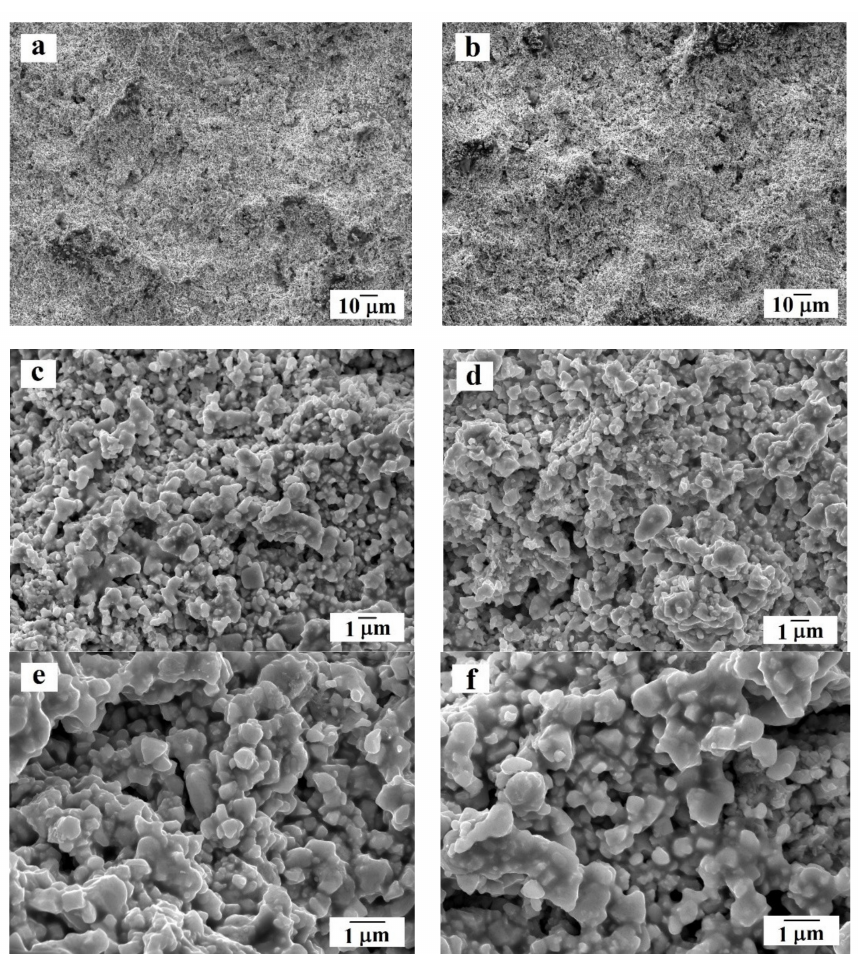
Figure 5. Surface morphology of the coatings: ( a , c , e ) sample of batch 1; ( b , d , f ) sample of batch